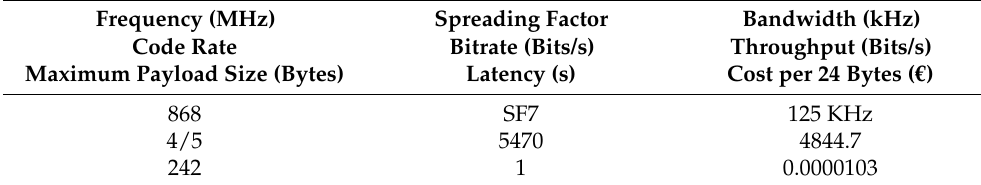
Table 2. Operating features of Helium Node.